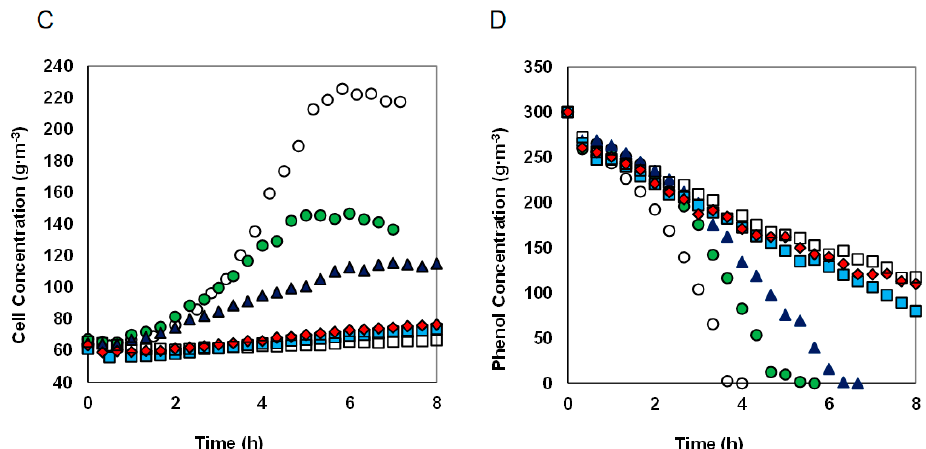
Figure 2. The effect of the nickel concentrations on the biomass growth and phenol utilization in two series of cultures for different initial phenol concentrations of 100 ( A , B ) and 300 g · m − 3 ( C , D ). Nickel concentrations, g · m − 3 : 0 ( ○ ), 1.67 ( ● ), 3.33 ( ▲ ), 6.67 ( ■ ), 10 ( ♦ ), 13.33 ( □ ).